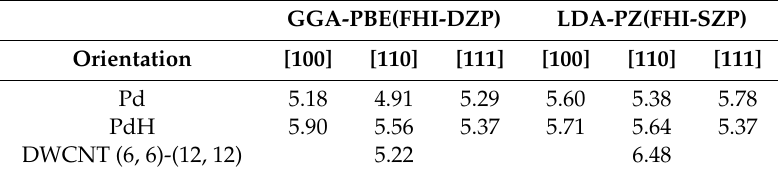
Table 2. Work functions calculated by